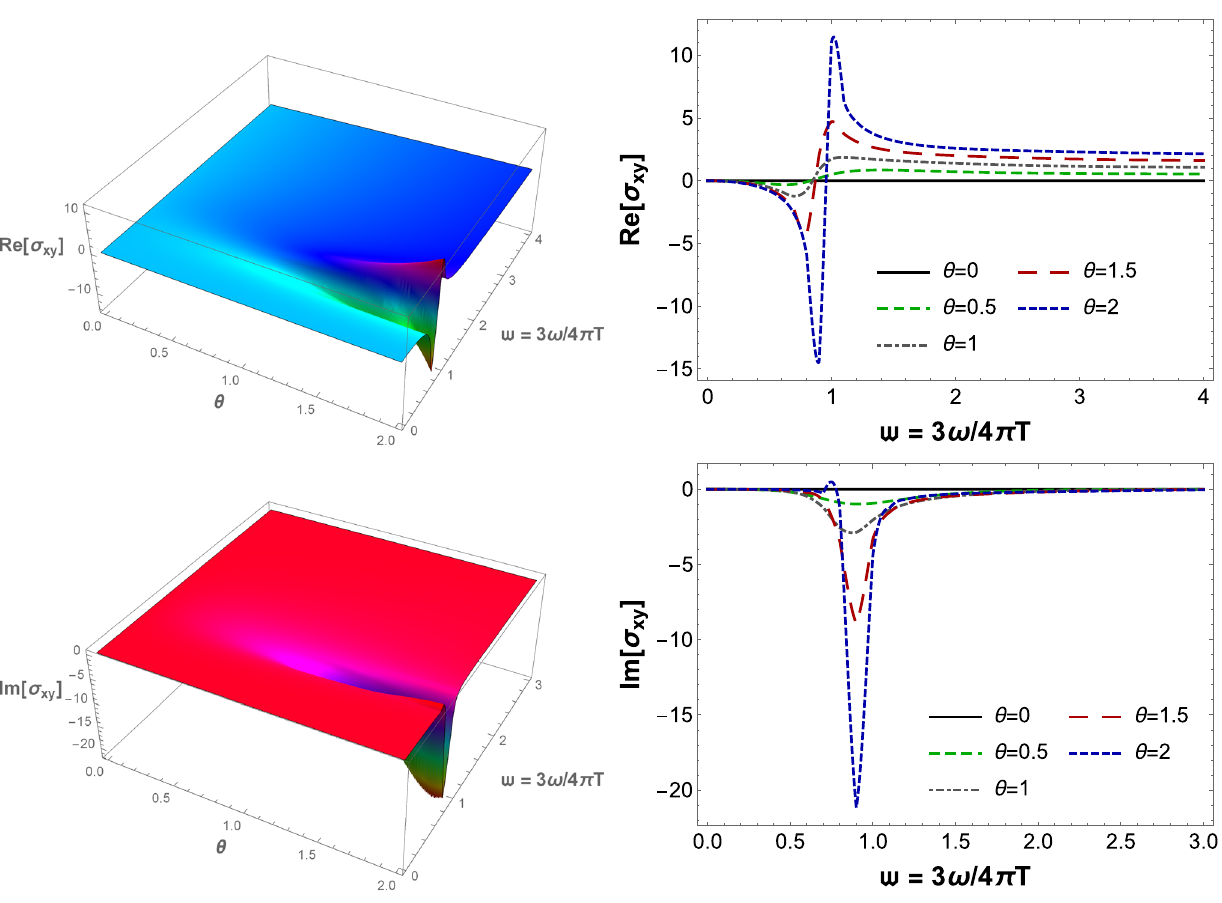
ing the characteristic mass scale (cid:12) of the bulk monopole